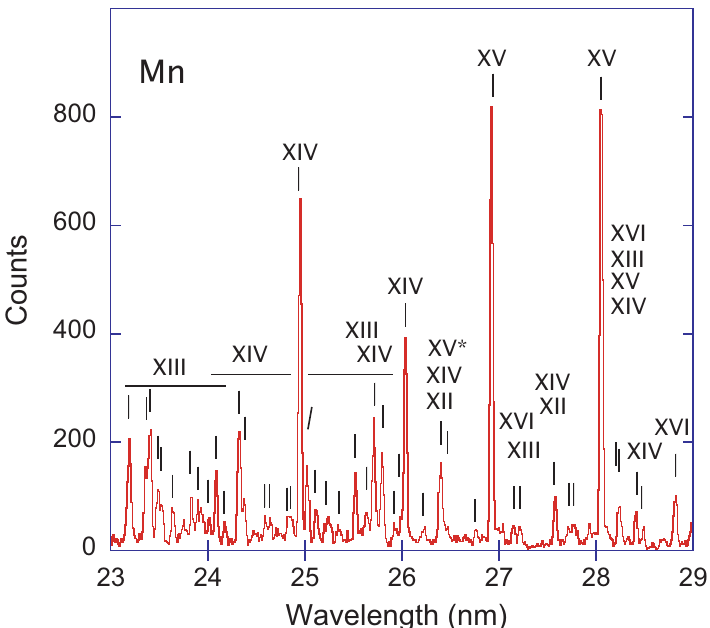
Figure 19. Beam-foil spectrum of Mn at an ion beam energy of 27MeV. Observation 1mm down- stream of the foil (delay 90ps). Line width (FWHM) 0.038nm. The strongest lines are identified by the spectrum number. In several sections there appear many lines of the same spectrum, which have been marked by horizontal bars. At several positions, two to four known lines coincide within a line width. There is a multitude of weak lines that do not all agree with literature line